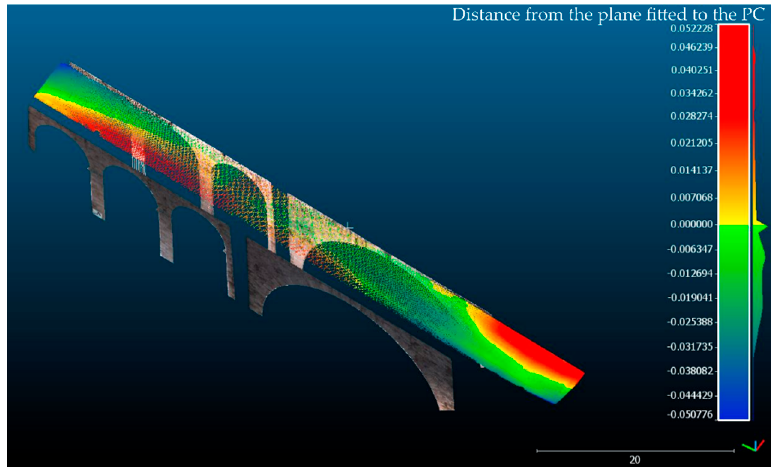
Figure 14. Distances from the plane best fitted to the PC captured to detect deformations.